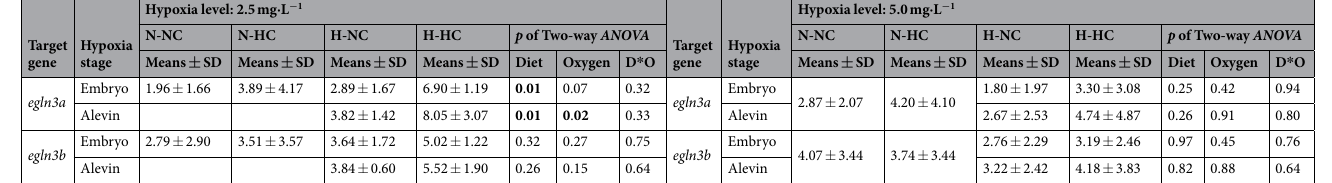
Tables 2. Effects of early hypoxia and high-carbohydrate diet at first-feeding on mRNA level of egln3a and egln3b . N-NC, N-HC, H-NC and H-HC stands for fish subjected to normoxia and no carbohydrate diet, normoxia and high carbohydrate diet, hypoxia and no carbohydrate diet and hypoxia and high carbohydrate diet, respectively. Data were presented as mean ± SD (n = 6), statistical differences were evaluated by two-way ANOVA ( p < 0.05, values in bold).